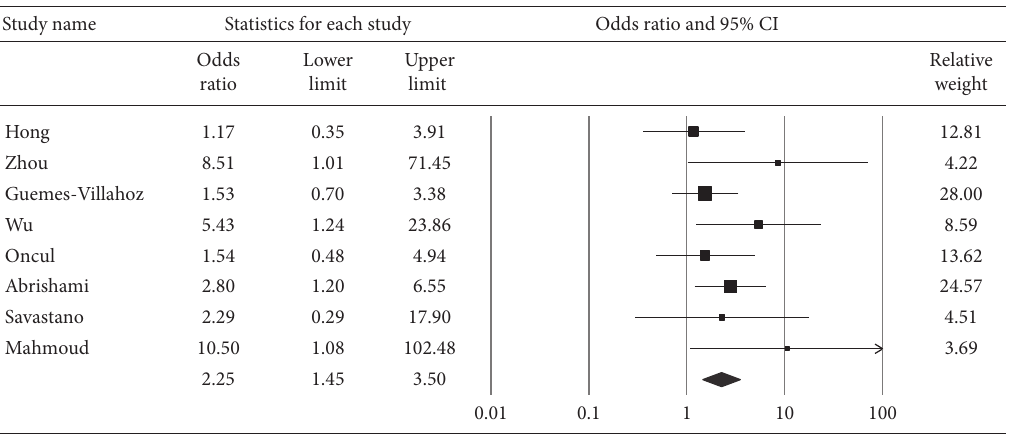
Figure 8: Pooled odds ratio for ocular manifestations among severe pneumonia relative to mild-to-moderate